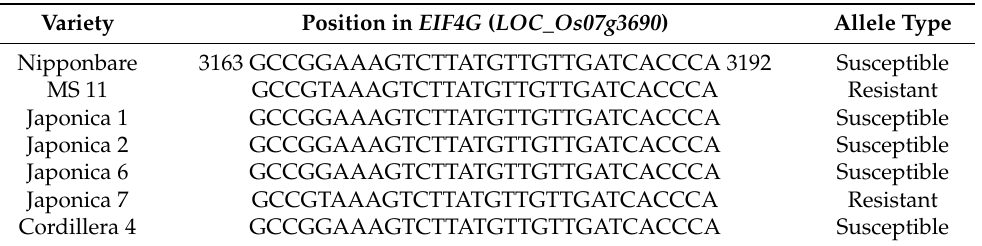
Table 5. Sequences of the 30-bp region (3163 to 3192) of EIF4G ( LOC_Os07g3690 ) in the six tem- perate japonica rice varieties developed under the GUVA project and an RTSV-susceptible variety, Nipponbare.